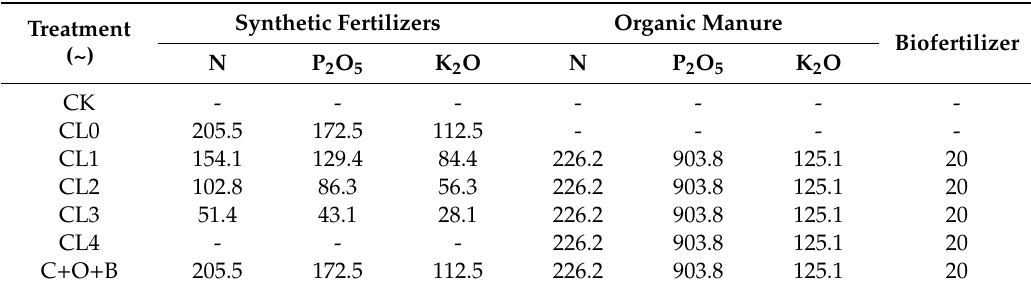
Table 2. Application combinations with amount of biofertilizer, synthetic fertilizers (kg ha − 1 ) applied to di ff erent concentrations rates during winter wheat growing seasons 2013–2018.